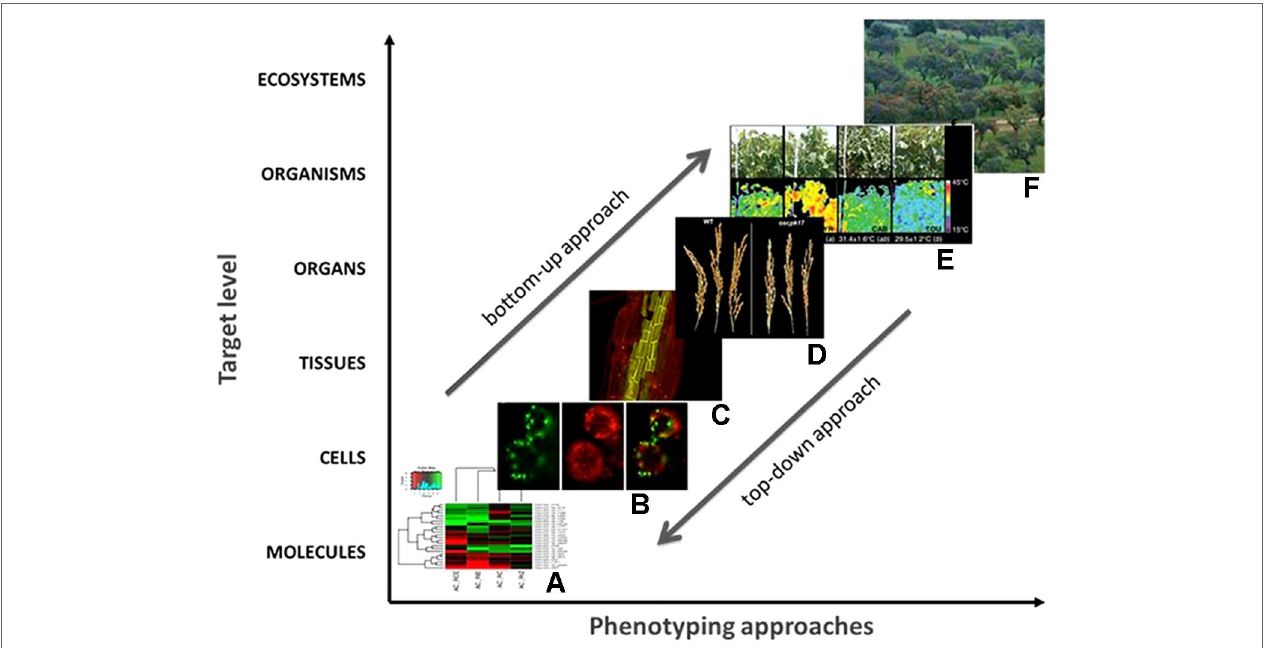
FIGURE 1 | Phenotyping at different scales and levels of plant biological organization: from the molecular level (A) until the plant (E) and ecosystem level (F) . Arrows indicate the complementarity between different phenotyping levels and the need of integrating phenotyping outputs for improved practical application e.g., in crop selection and breeding. Different plant species were used as examples ( Quercus suber L., Fontinalis antipyretica Hedw., Arabidopsis thaliana L., Oryza sativa L., and Vitis vinifera